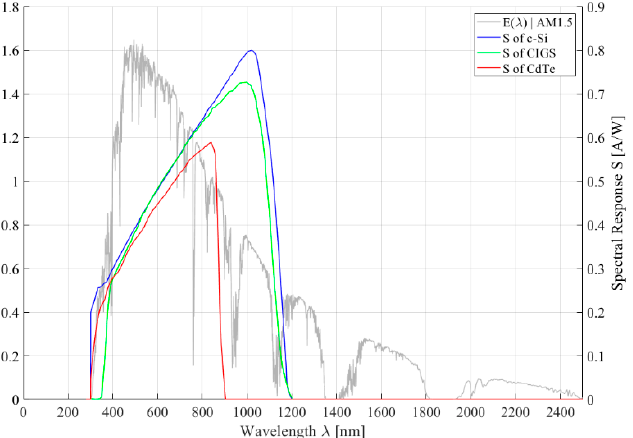
Figure 4. AM1.5 spectrum and spectral response S of the considered c ‐ Si, CIGS and CdTe PV